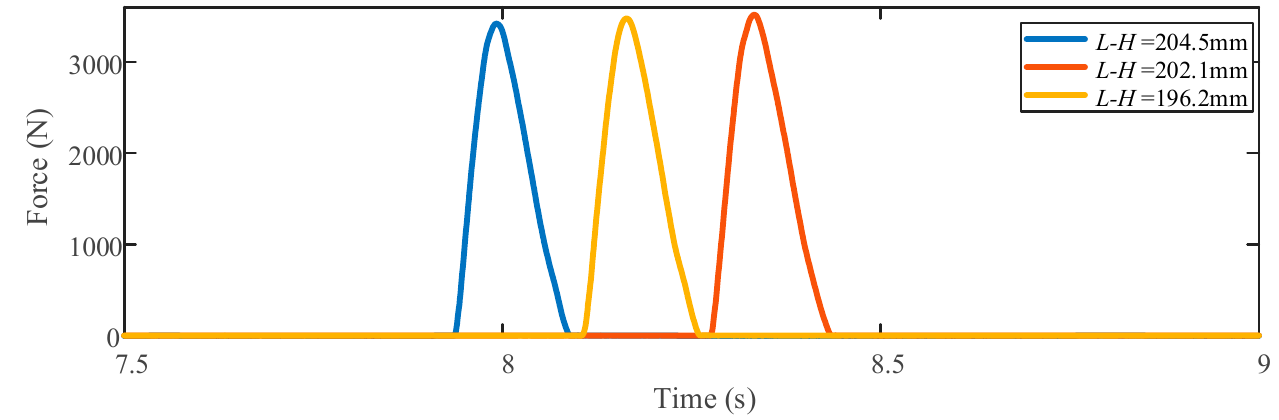
Figure 7. Impact forces when dynamic-breakdowns occur.